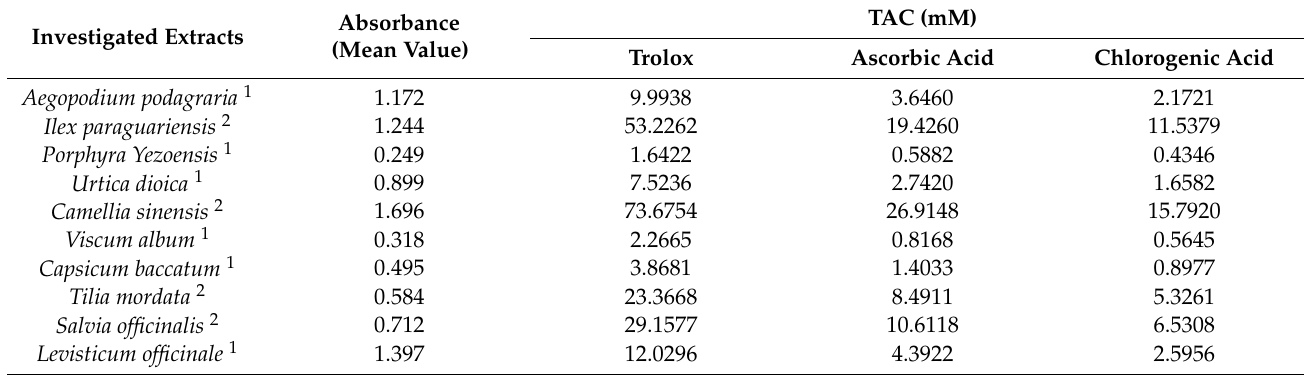
Table 6. The values of the equivalents of the reference substances, i.e., Trolox, ascorbic acid, and chlorogenic acid, for the tested extracts, calculated on the basis of calibration curves made by the SNAPC